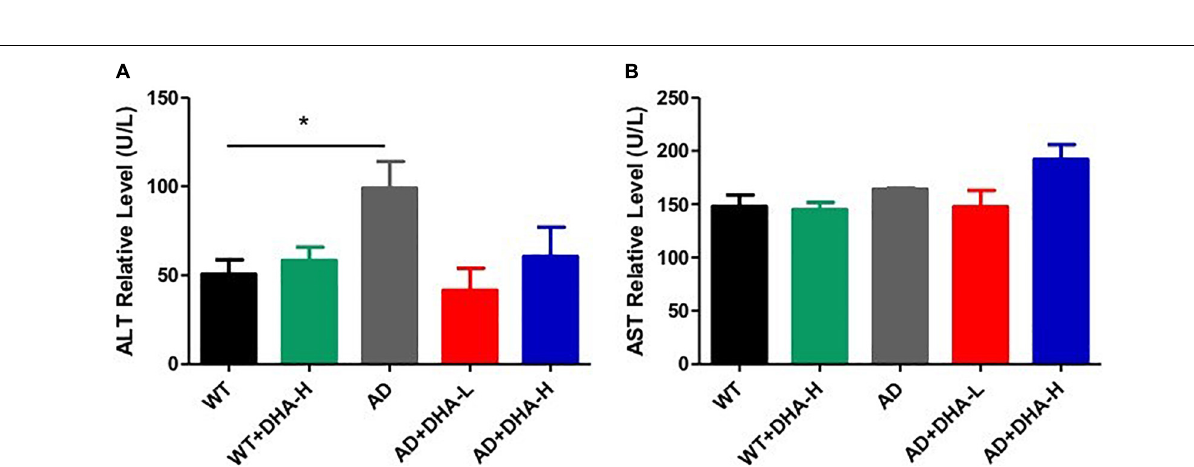
FIGURE 6 | Effect of DHA treatment on neurofibrillary tangles in the hippocampus and cortex of 2 × Tg AD mice ( n = 4).